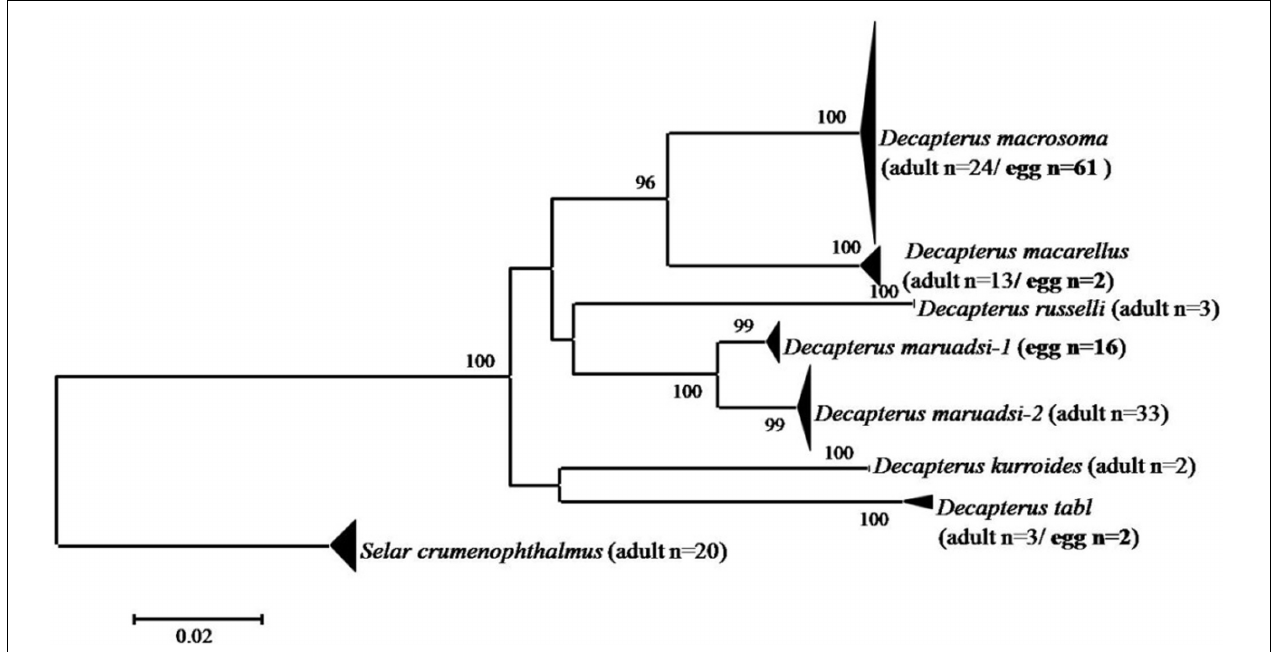
FIGURE 4 | Neighbor-joining tree of fish egg sequences combined with local DNA barcode library of Decapterus species. The numbers at the nodes are bootstrap values based on 1,000 replications.